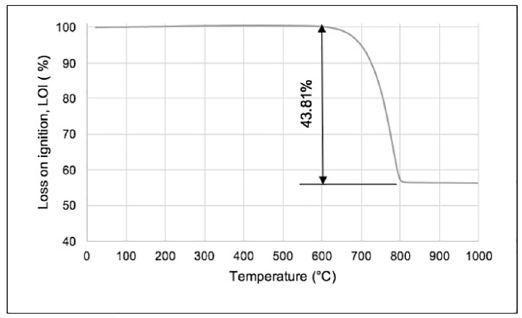
Figure 3. Marble waste thermogravimetry